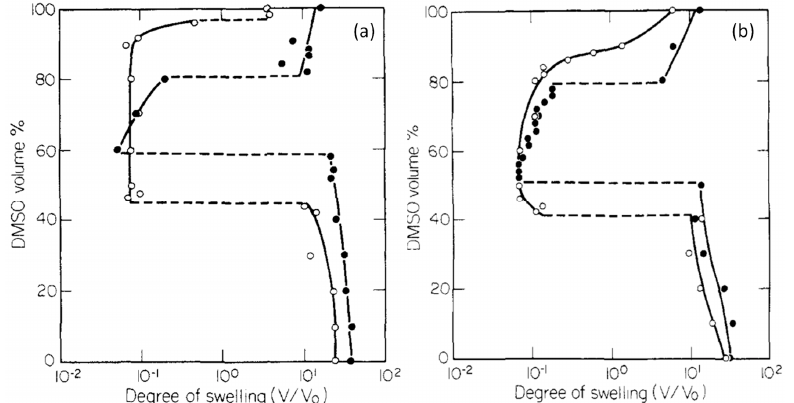
Figure 4. Equilibrium swelling degree ( V/V o ) of ionic PDEAA ( a ), and PNIPAM hydrogels ( b ) in DMSO/water mixtures of various compositions. The ionic comonomer (NaAAc) contents are 7 (open symbols) and 14 wt % (filled symbols). From [9] with permission from the American Chemical Society.